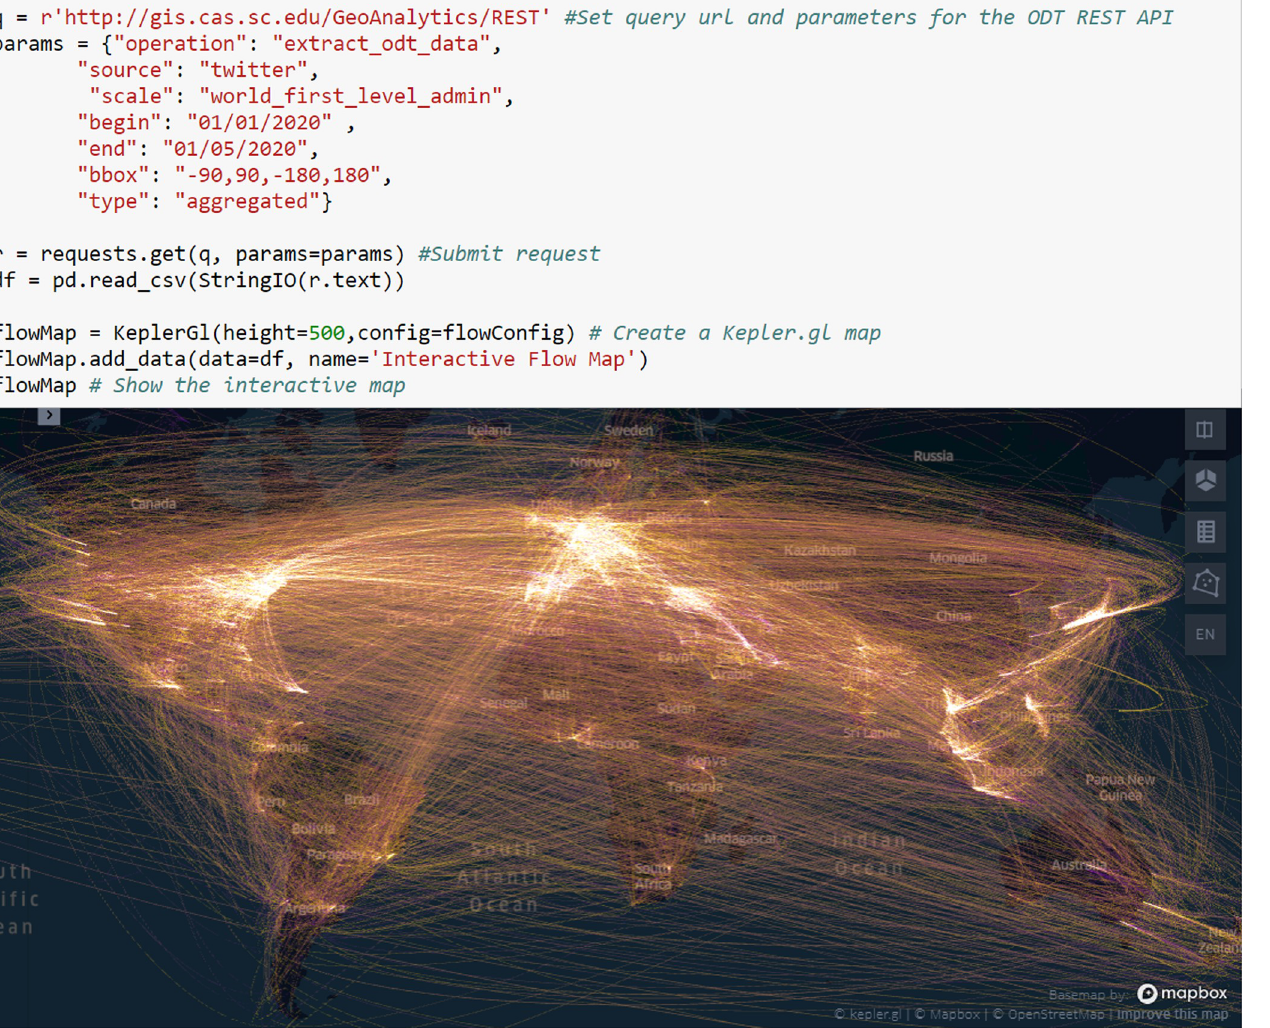
Fig 16. Python code of extracting the world first-level administrative OD flow matrix using the ODT Flow API and visualizing the data as an interactive flow map with kepler.gl.